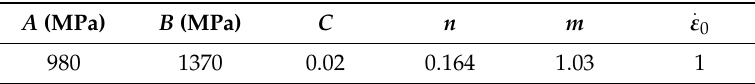
Table 1. Johnson–Cook parameters for IN718